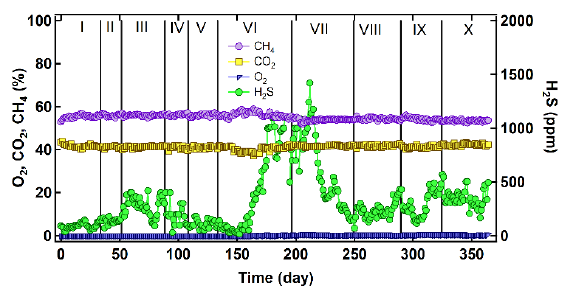
Figure 6. Biogas composition during the monitoring period of the full-scale plant.